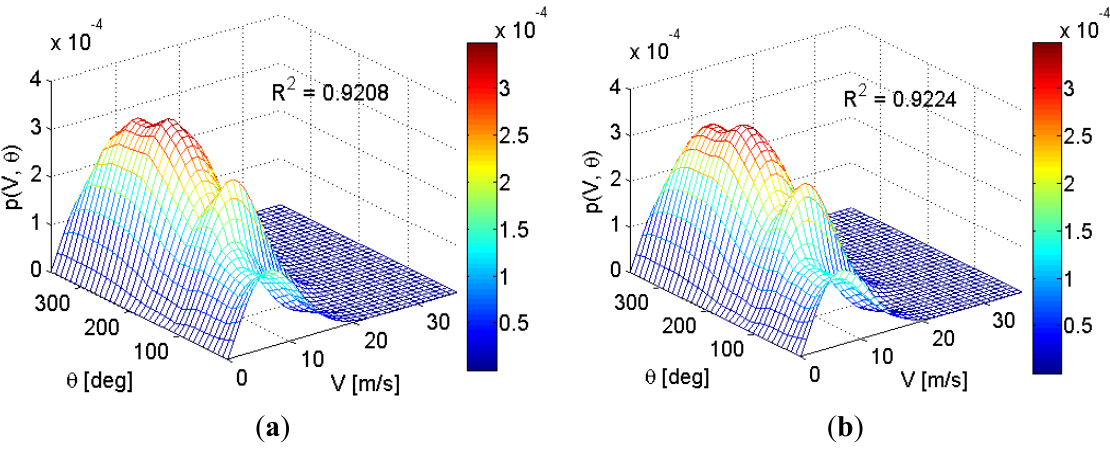
Figure 7. Bivariate PDF of wind speed and wind direction at the hub height for model: ( a ) using linear interpolation; ( b ) using spline interpolation.